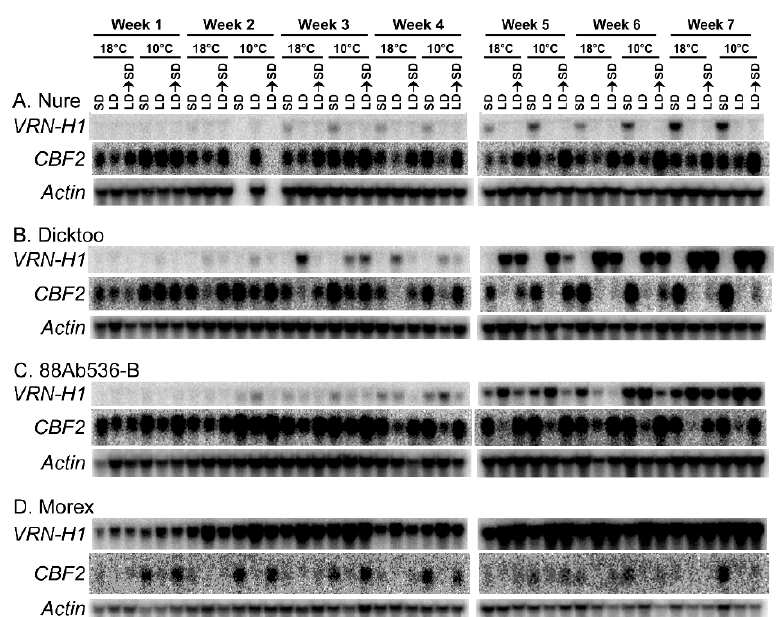
Figure 6. VRN-H1 and CBF2 expression in ‘Nure’, ‘Dicktoo’, 88Ab536-B, and ‘Morex’ under SD and LD photoperiod over seven weeks. Each lane was loaded with 7 μ g total RNA isolated from crowns. Filters were hybridized together in the same solution to each respective probe. Plants were grown under a light/dark cycle of 8 h/16 h (SD) or 16 h/8 h (LD) using 650 μ M m − 2 s − 1 light. Tissue was harvested 6 h after subjective daybreak from the SD plants, and 14 h after subjective daybreak from the LD plants. At daybreak the day after the harvest of the 18 °C sample set, the growth chamber temperature was decreased to 10 °C. Tissue was then harvested that same day. The day following the temperature decrease to 10 °C, the growth chambers were returned to 18 °C. Concurrently a set of two pots of each genotype were transferred from the LD chamber to the SD growth chamber. This cycle was repeated for seven weeks. The lanes marked LD → SD are from a set of plants (two pots each genotype) that were moved from the LD chamber to the SD growth chamber five days prior to the 18 °C temperature tissue harvest. Transfers were made at weekly intervals starting the second week after germination.